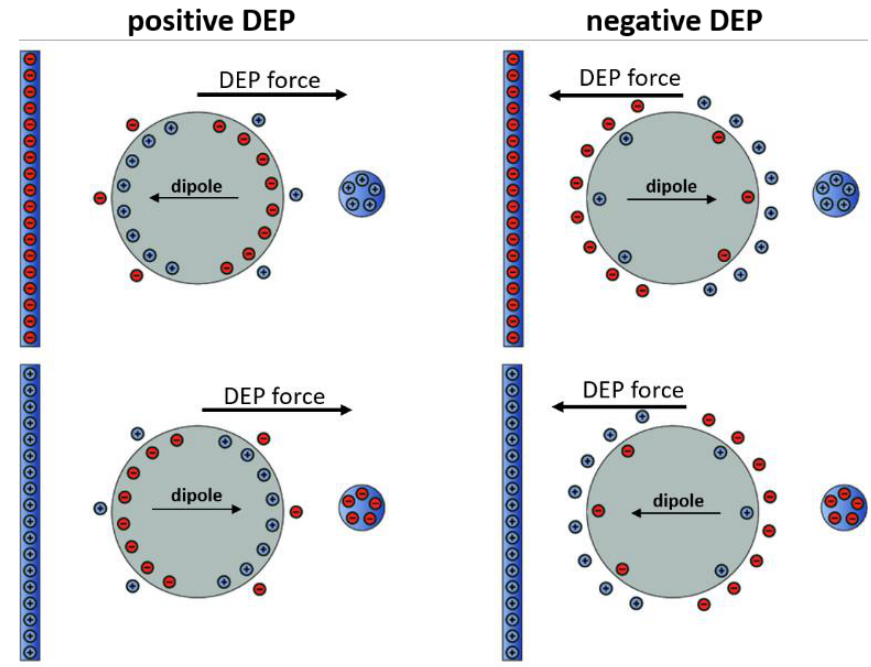
Figure 1. Polarization, induced net dipole and dielectrophoretic force direction for a particle that is ( left ) more polarizable than the surrounding medium and ( right ) less polarizable. Top and bottom are two opposite arrangements of the background electric field (adapted from ref. [14]).